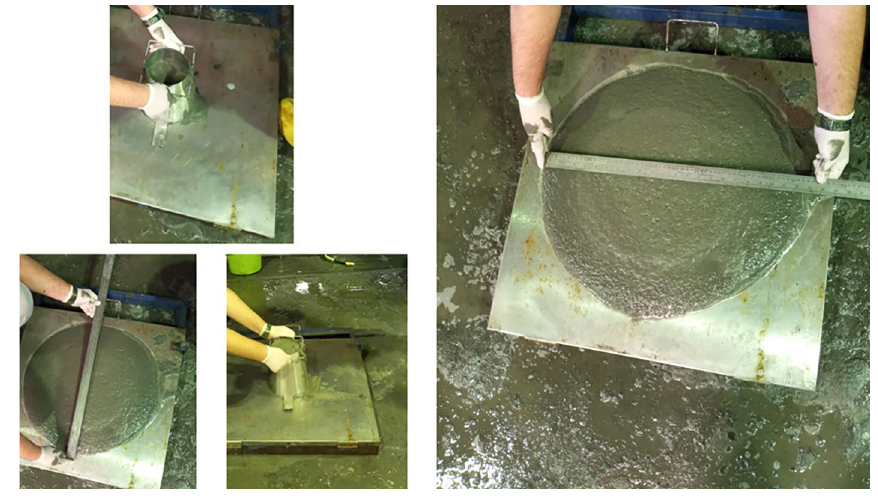
Figure 3. The flow table test setup and